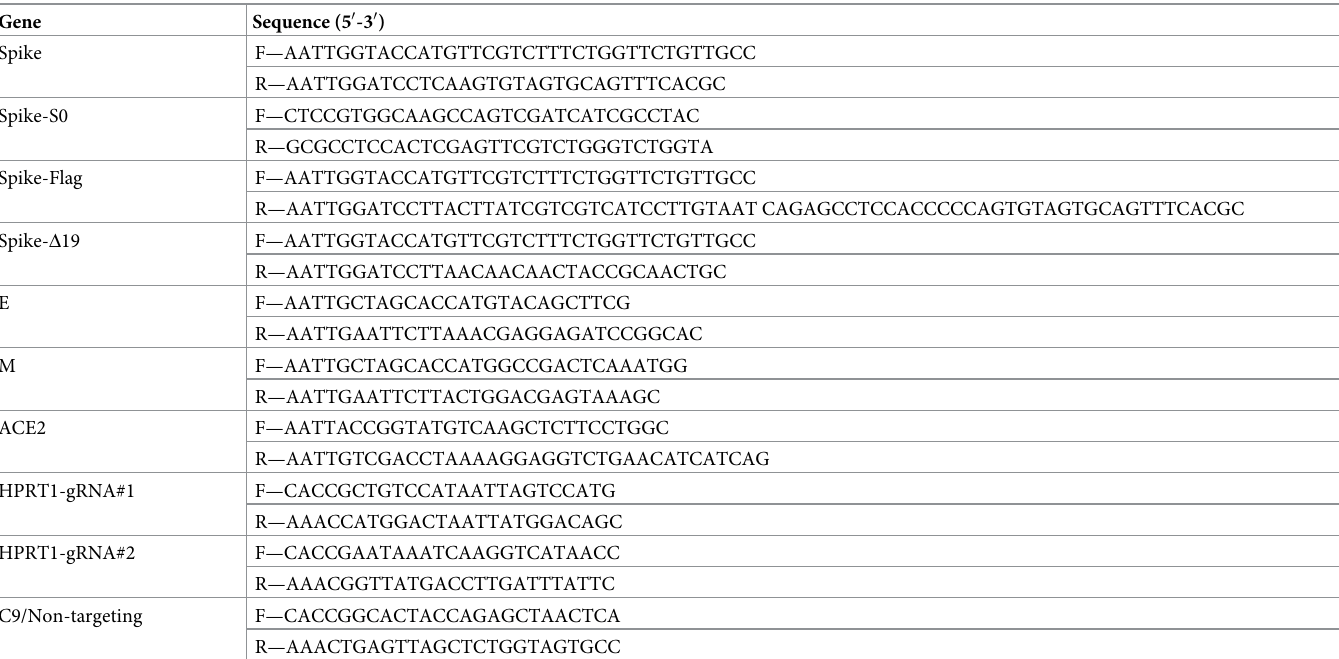
Table 2. Primers used for cloning and PCR